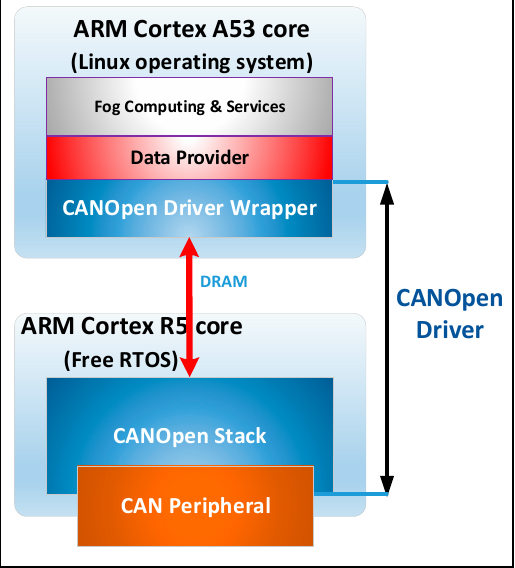
Figure 5. The software architecture of the CANOpen fieldbus driver.